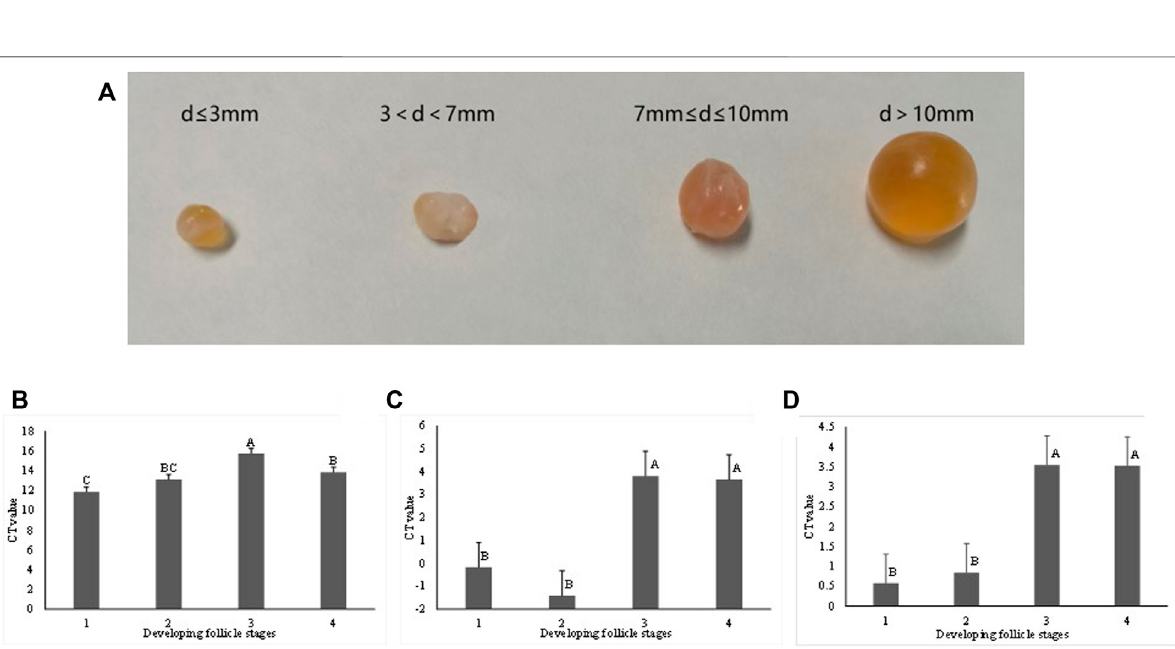
Frontiers in Genetics |